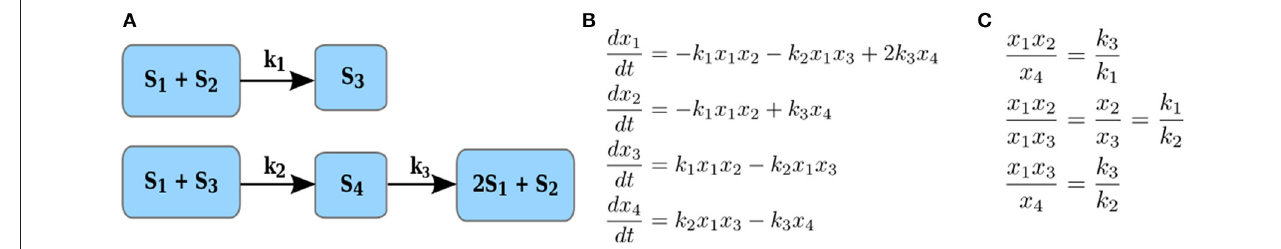
FIGURE 2 | Illustration of reaction couplings. (A) Network with four components, S1–S4, and three reactions with rate constants k1–k3; (B) A system of ODEs with mass action kinetics describing the change in concentration of each of the four components. (C) Couplings of reaction rates by invoking the steady-state assumption for the system of ODEs in (B)